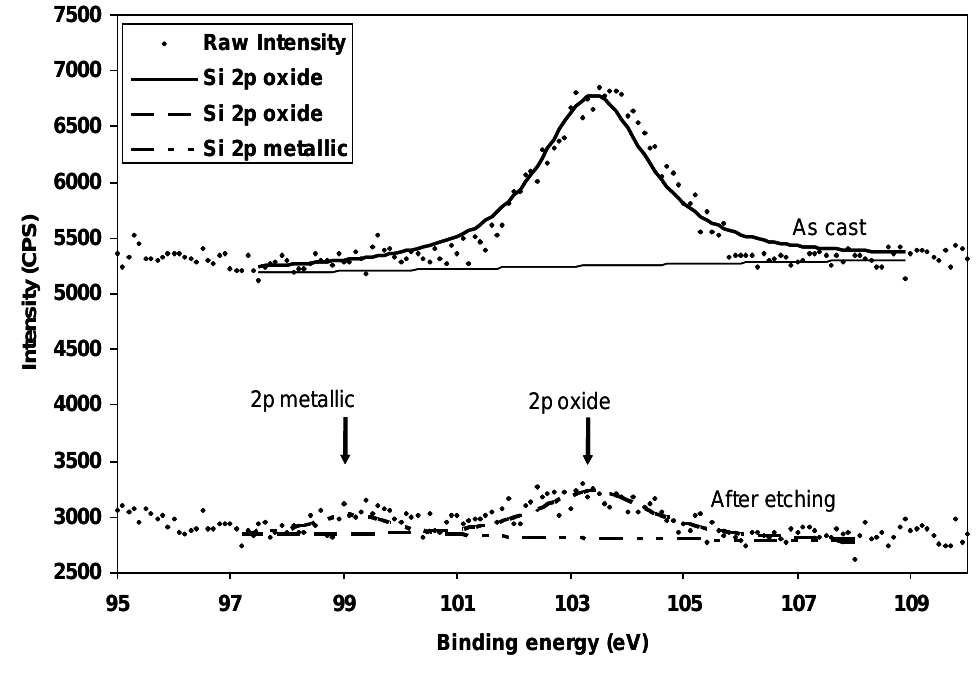
Figure 10. XPS Si 2p peak fitting for standard SiO